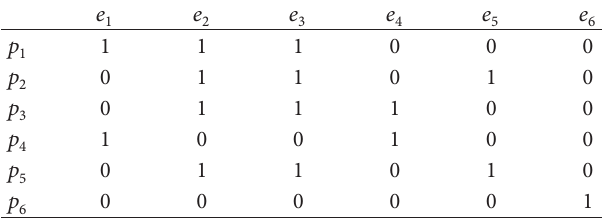
Table 2: Coverage pattern of transmitters ( 𝑡 1 to 𝑡 6 ) in the matrix